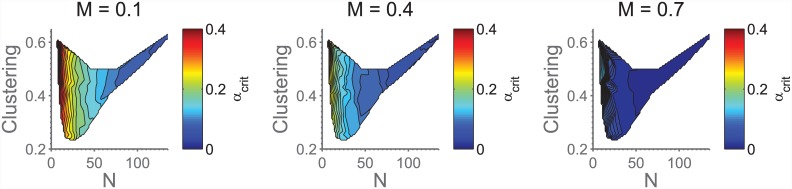
Measured αcrit for various realizations of the social networks.We see that in particular the N-based variation is strong. The coloured region coresponds to the (0, 15) × (0, 35)-region in (f1, f2)-space; see the appendix for an explanation of f1, f2.